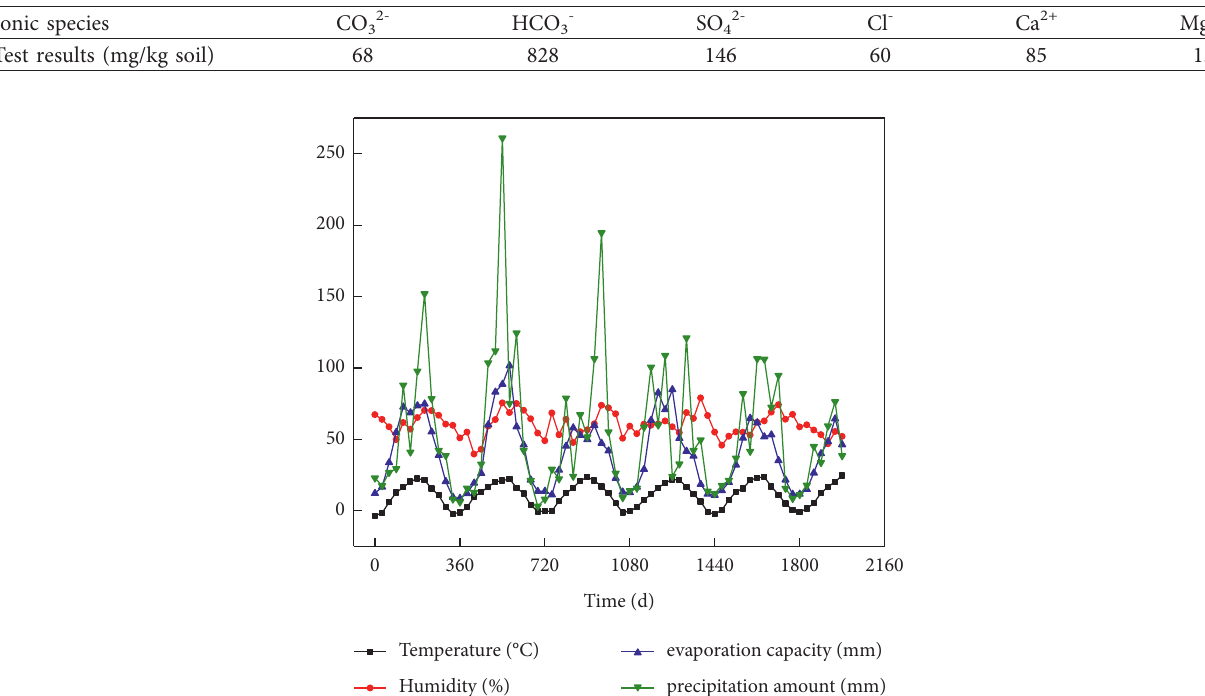
Table 1: Soil quality analysis report of saline soil.